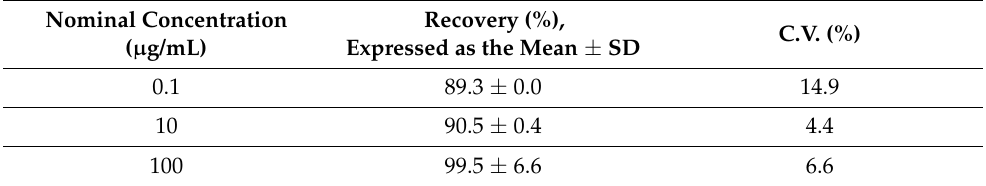
Table 2. The absolute recovery of C1 from rat plasma with RP-HPLC. The recovery of C1 in rat plasma, tissues and organs was carried out by comparing the average of the maximum areas of the quality control standard with those of the samples containing the standard solutions added to the matrix (plasma, tissues and organs), which had the same final concentration as the pure standards. The recovery of C1 was assayed in triplicate at concentrations of 0.1, 10, and 100 µ g/mL. The mean ± standard deviation (SD) of the percentage of absolute recovery is reported. The coefficient of variation (C.V., %) was determined for each of the evaluated concentrations of C1